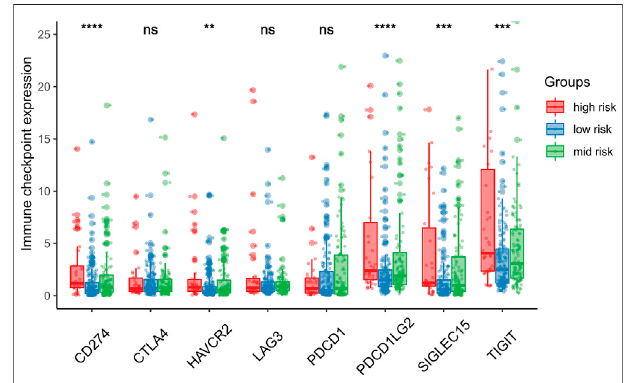
FIGURE 8 | Association between risk score and immune checkpoint. SIGLEC15, TIGIT, CD274, HAVCR2 and PDCD1LG2 expression mainly expressed in the high-risk score group. * p < 0.05; ** p < 0.01; *** p <